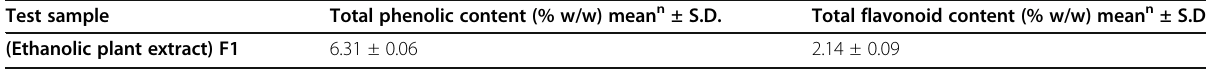
Table 2 Total phenolic and flavonoid content in the ethanolic extract of plant Cineraria maritima Test